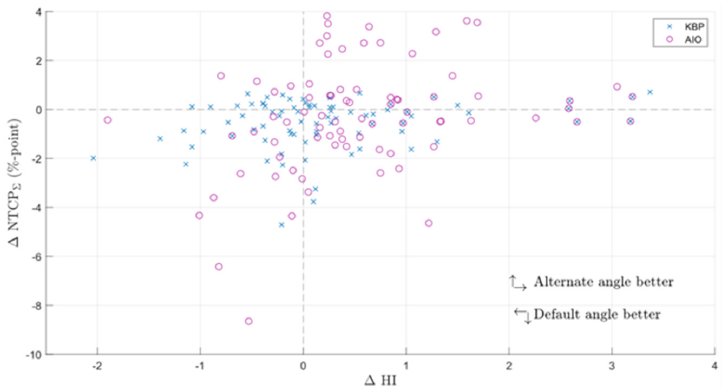
Figure 3. Difference in the sum of grade 2 NTCP endpoints and HI between KBPs with default and alternate beam angles (default minus altered). ∆ NTCP Σ = difference in the sum of grade 2 normal tissue complication probabilities; KBP = knowledge-based plan; AIO = automatic iterative optimizer-generated plan.